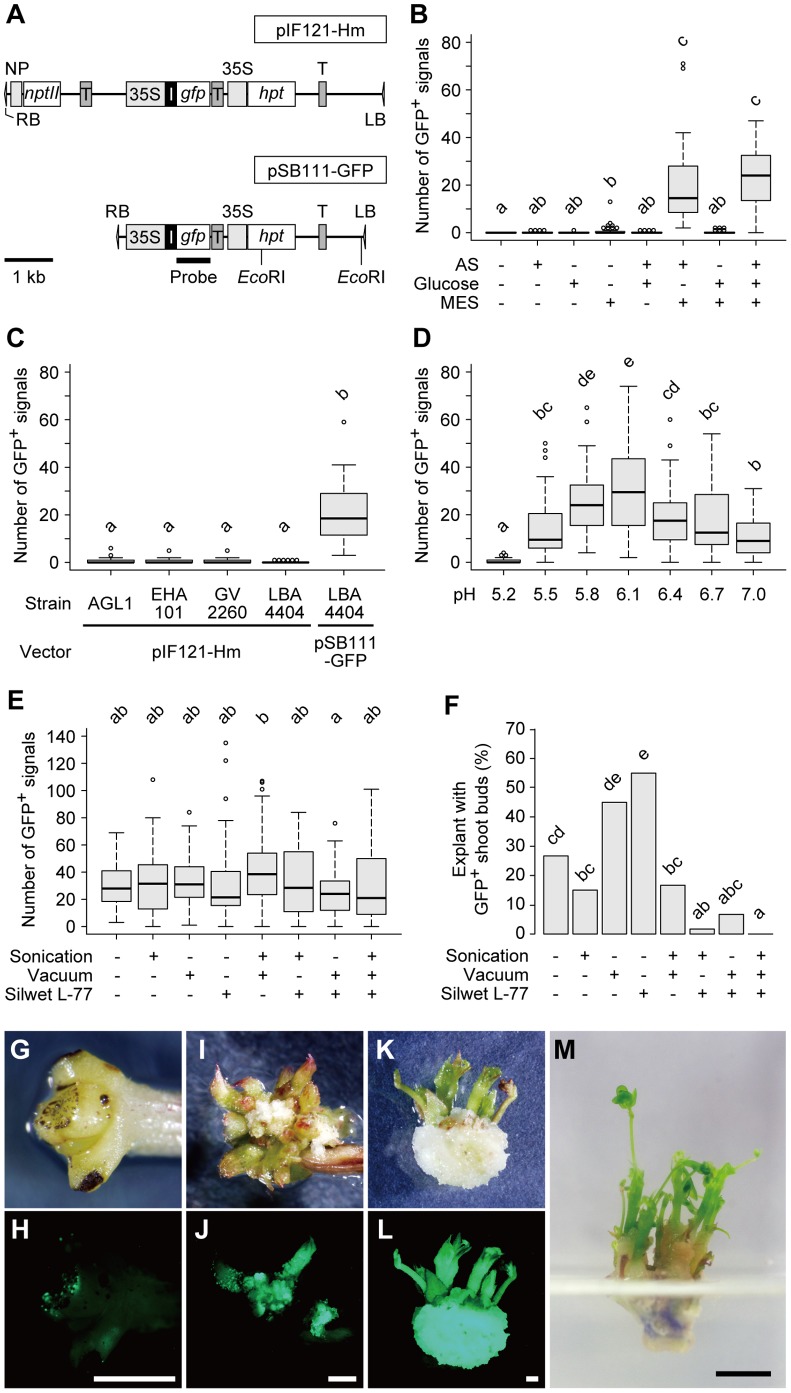
Optimization of Agrobacterium infection conditions.A. Schematic representations of the T-DNA regions of the binary vectors. The position of a probe used for Southern blot analysis and the EcoRI cutting sites are shown for pSB111-GFP. RB, right border [72]; LB, left border [72]; 35S, CaMV 35S promoter [73]; NP, NOS promoter [74]; T, NOS terminator [74]; I, first intron of the castor bean CAT-1 gene [37]; nptII, neomycin phosphotransferase II gene [75]; hpt, hygromycin phosphotransferase gene [76]; and gfp, sGFP gene [35]. B. Effects of co-cultivation in the presence of acetosyringone (AS), D-glucose, and MES buffer on transformation efficiency (n = 40). The pH of each medium was adjusted to 5.8 before autoclaving. C. Effects of Agrobacterium strains and vectors on transformation efficiency (n = 40). Co-cultivation medium containing acetosyringone, glucose, and MES (pH 5.8) was used. D. Effects of initial pH of co-cultivation media (n = 60). E, F. Effects of sonication, vacuum infiltration, and Silwet L-77 detergent treatments prior to co-cultivation (n = 60). The number of GFP-positive signals on the cotyledonary node of each explant was counted after 10 days of selection (B–E). The frequency of explants possessing GFP-positive shoot buds was counted after 30 days of selection (F). Significant differences were observed between two groups that do not share the same lowercase letter [P<0.05 by the Steel-Dwass test (B–E) or Fisher's exact test with Holm's P-value adjustment (F)]. G–J. Bright-field (G, I) or green fluorescent (H, J) images of cotyledonary node explants after 10 (G, H) or 30 (I, J) days of selection. K, L. Bright-field (K) or green fluorescent (L) images of an isolated GFP-positive callus after 51 days of selection. M. After an additional 21 days of cultivation (a total of 72 days), the same callus shown in (K) formed multiple shoots with compound leaves. Scale bars, 1 mm (G–L), 1 cm (M).